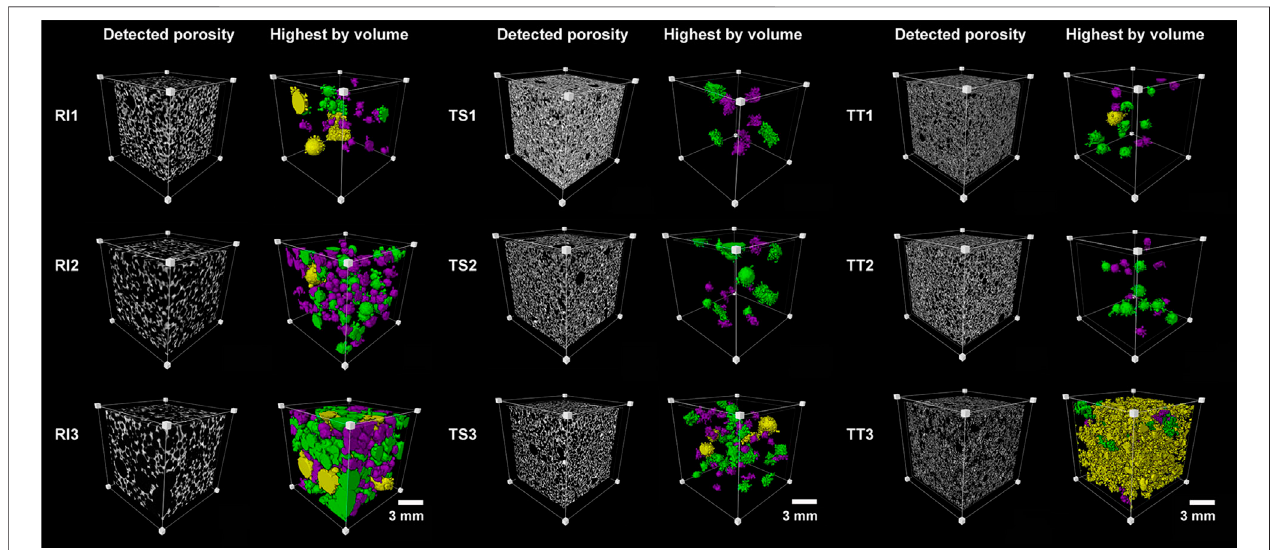
Frontiers in Materials |